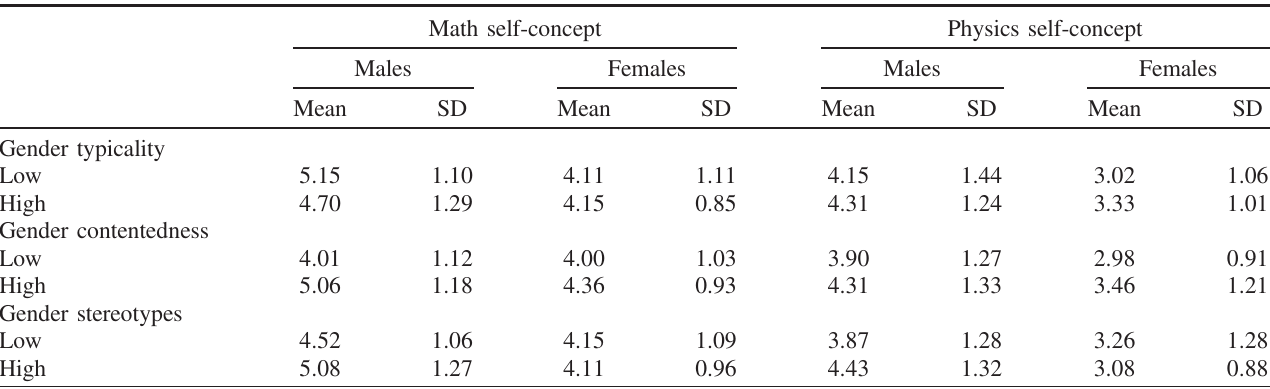
TABLE II. Math and physics self-concepts as a function of felt gender typicality and contentedness and level of endorsement of math- gender stereotypes.